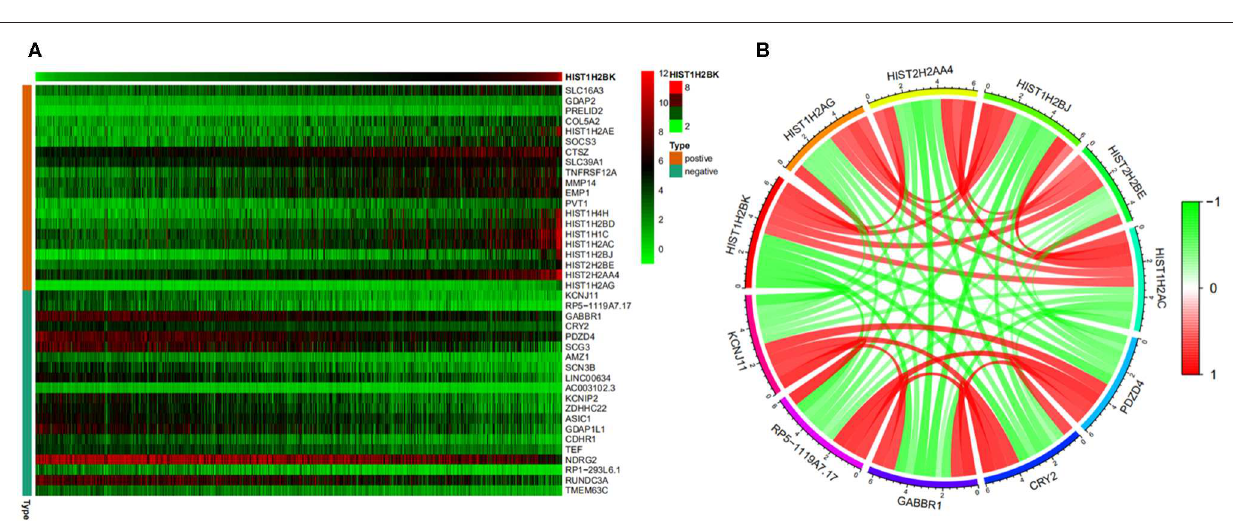
FIGURE 8 | Co-expression analysis of HIST1H2BK using the CGGA database (LGG + GBM, n = 749). (A) Heatmap of the top 20 genes positively and negatively associated with HIST1H2BK. (B) Circular plot of the top five genes positively and negatively related to the HIST1H2BK gene. Green represents negative association, and red represents positive